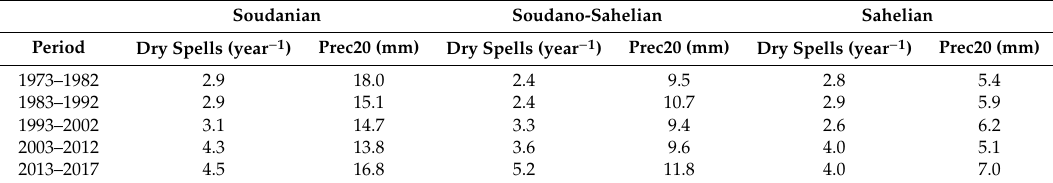
Table 5. Changes in dry-spell frequency (seven days or more without rain) and precipitation intensity ( > 20 mm day − 1 ) along the di ff erent agroclimatic zones (Soudanian, Soudano-Sahelian, and Sahelian) for the period 1973–2017.